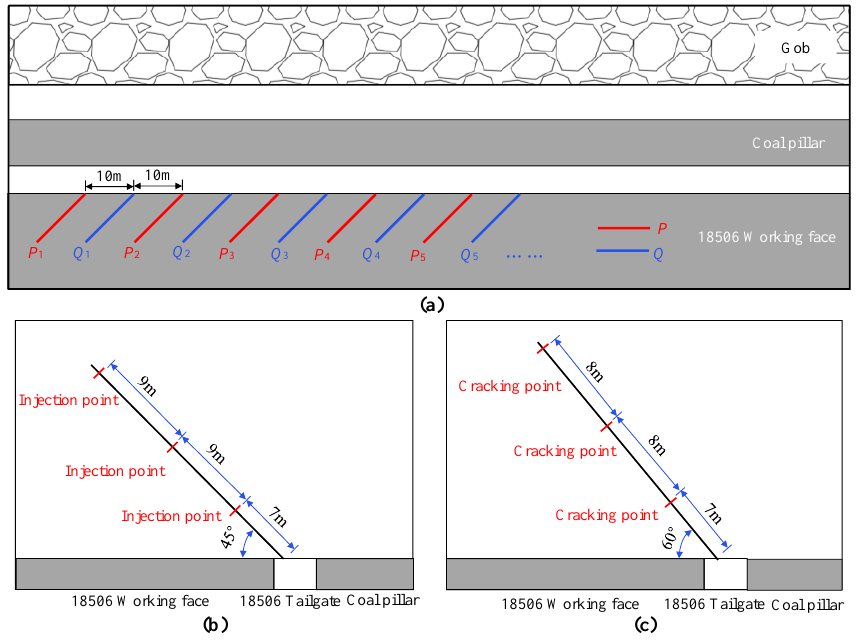
Figure 18. Layout of hydraulic fracturing boreholes in the 18506 working face: ( a ) layout of the drillings; ( b ) type P borehole; ( c ) type Q borehole. Table 3. Specific parameters of hydraulic fracturing drilling.